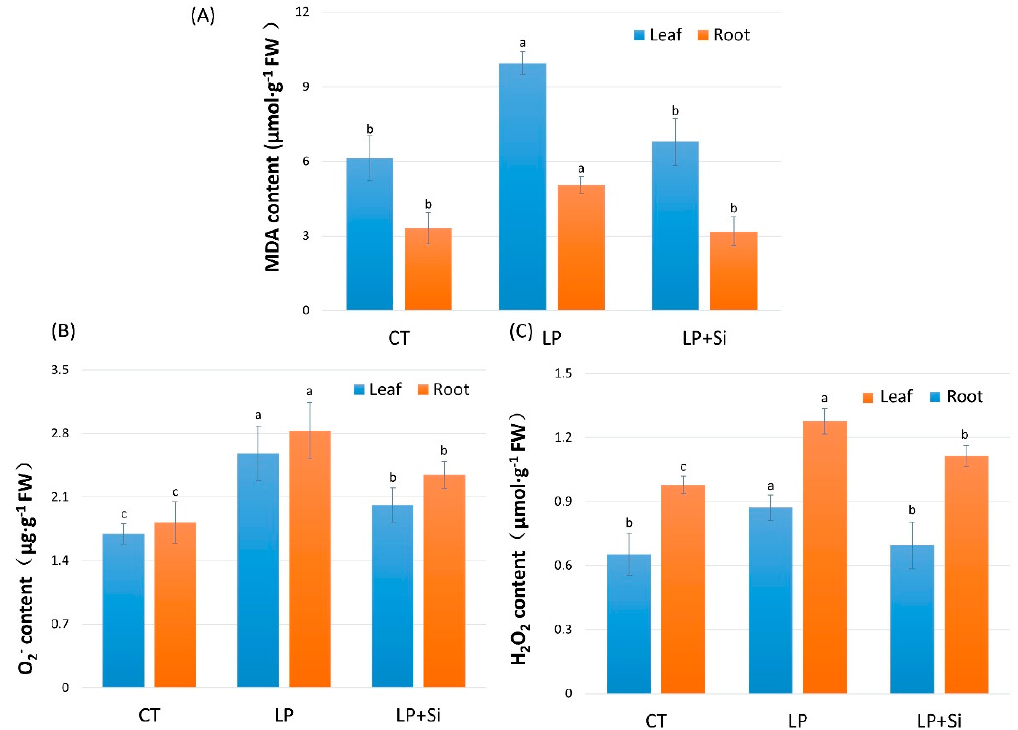
Figure 1. E ff ect of low phosphorus (LP) and silicon (Si) on lipid peroxidation and reactive oxygen species content in tomato plants: ( A ) Malondialdehyde (MDA) content, ( B ) O 2 − · content, and ( C ) H 2 O 2 content in tomato leaves and roots. Data are shown as means ± standard deviation (SD) of three replicates. Bars with the same color but di ff erent letters indicate statistically significant di ff erences at p ≤ 0.05. CT = normal phosphorus supply (P 0.66 mM); LP = low phosphorus supply (2 / 3rd of normal P); Si = 1.5 mM Si.